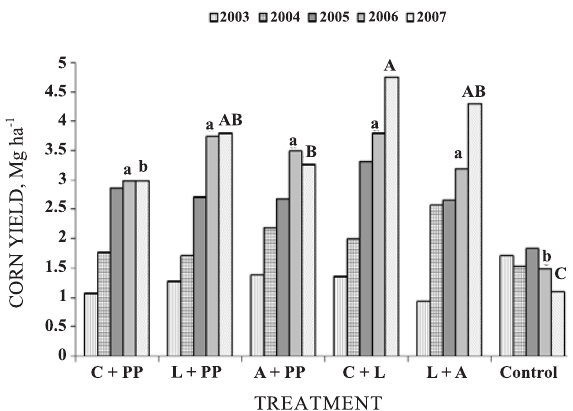
Figure 3. Corn yield over five years. Means for the same letters for all treatments, lower-case for 2006 and upper-case for 2007, did not differ significantly from each other (Tukey test at 5 %). C+PP: clitoria + pigeon pea; L+PP: leucaena + pigeon pea; A+PP: acacia + pigeon pea; C+L: clitoria + leucaena; L+A: leucaena + acacia.